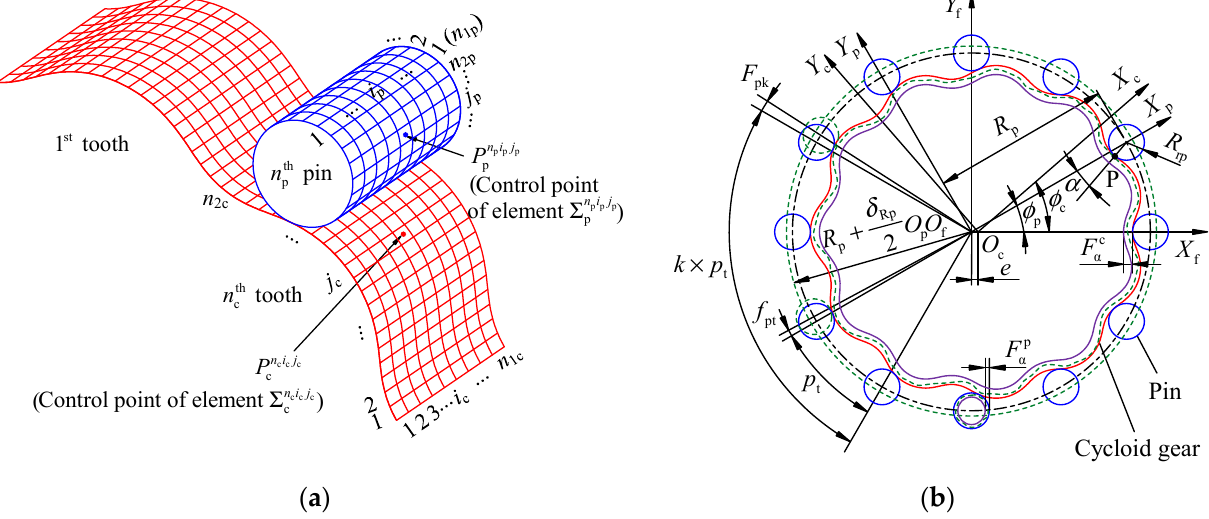
Figure 2. Tooth surface model: ( a ) discrete tooth surfaces and ( b ) coordinate systems for generating the tooth surfaces with PMs and MEs.